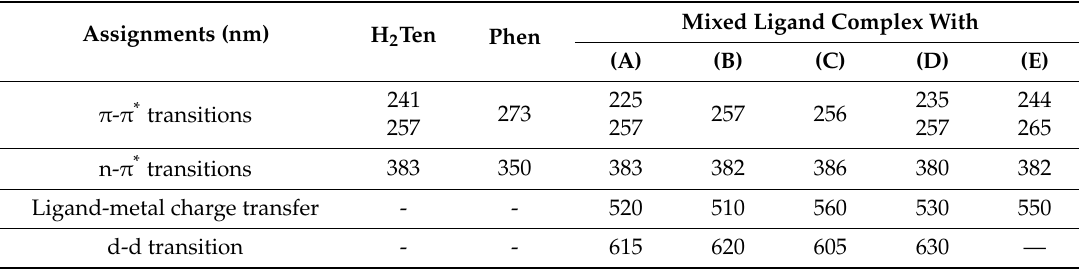
Table 2. UV–Vis. spectra for H 2 Ten, Phen and their metal